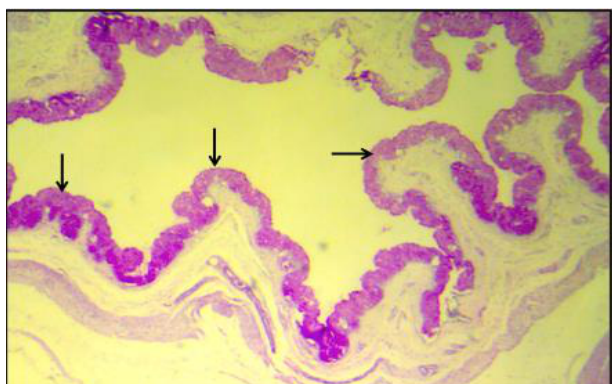
Figure 6. Vagina at fornix region showing folded mucosa lined with simple columnar mucous epithelium stained positively with PAS stain (black arrows). 40X, PAS